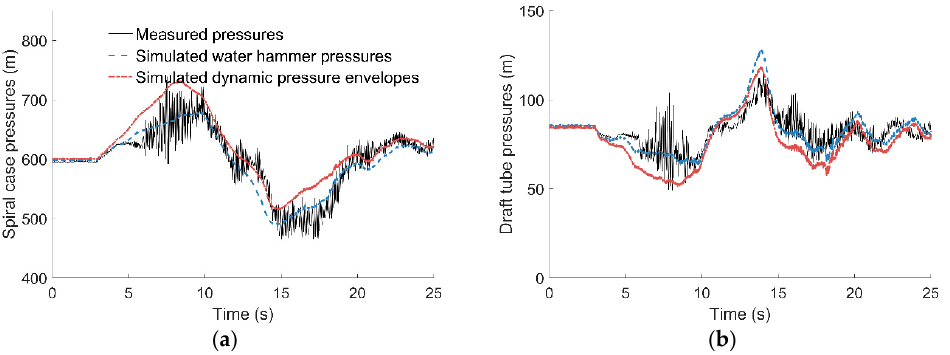
Figure 9. Comparison of measured and simulated rotational speeds.